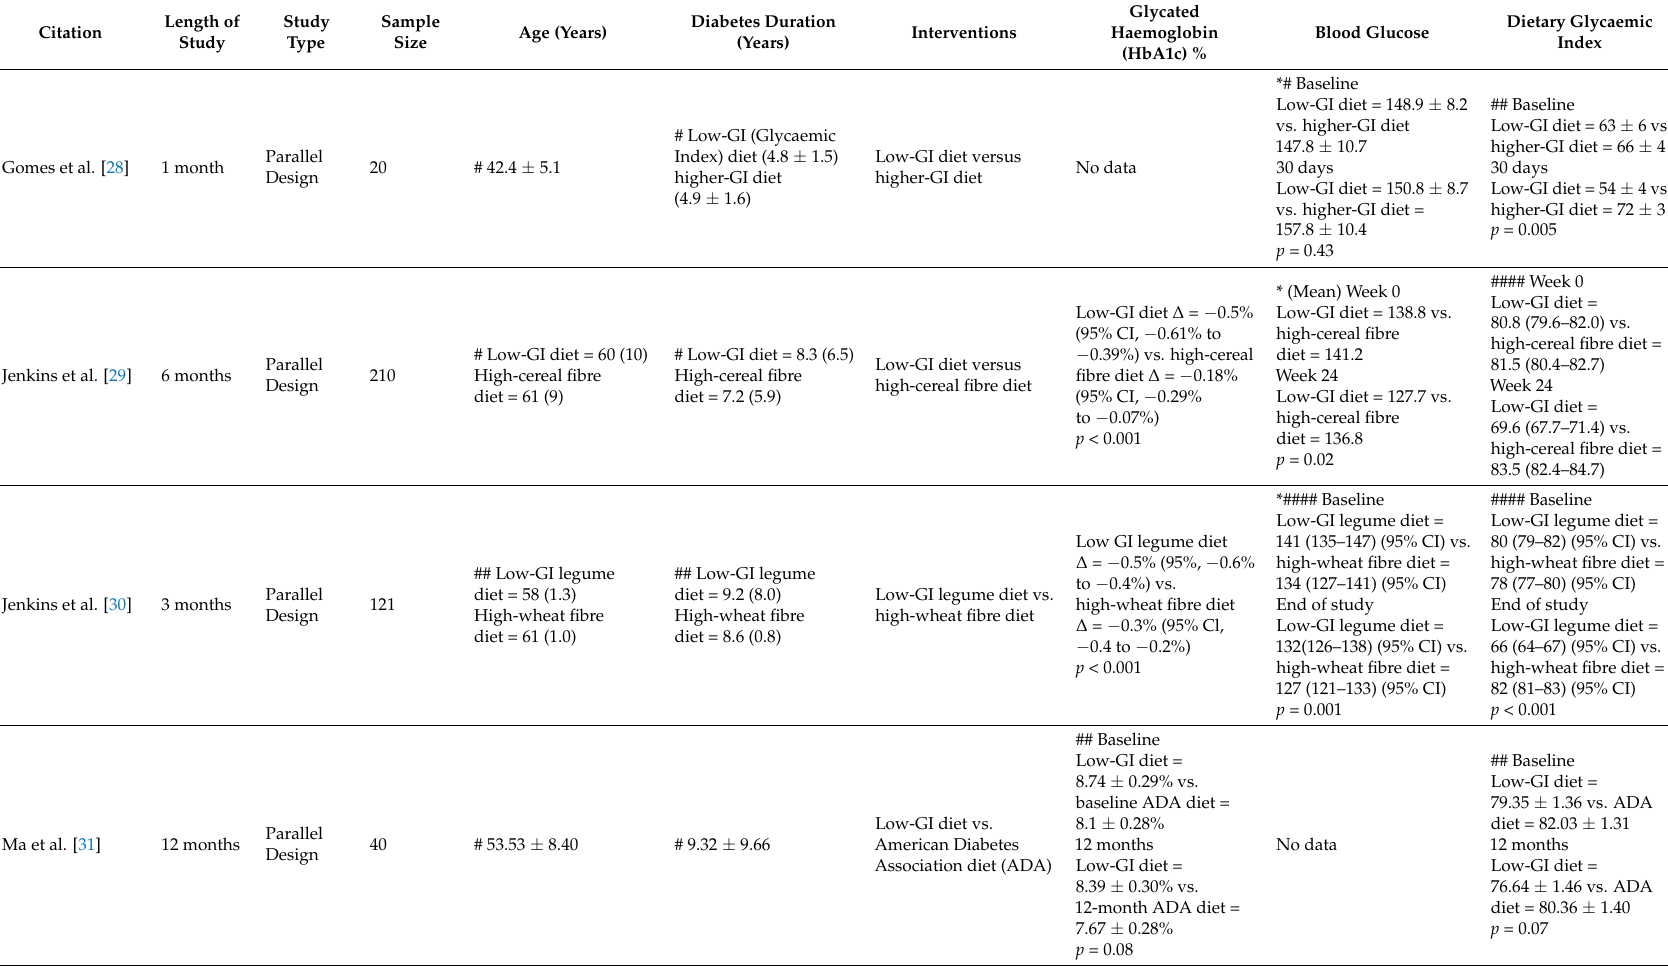
Table 3. Summary of studies included in the systematic